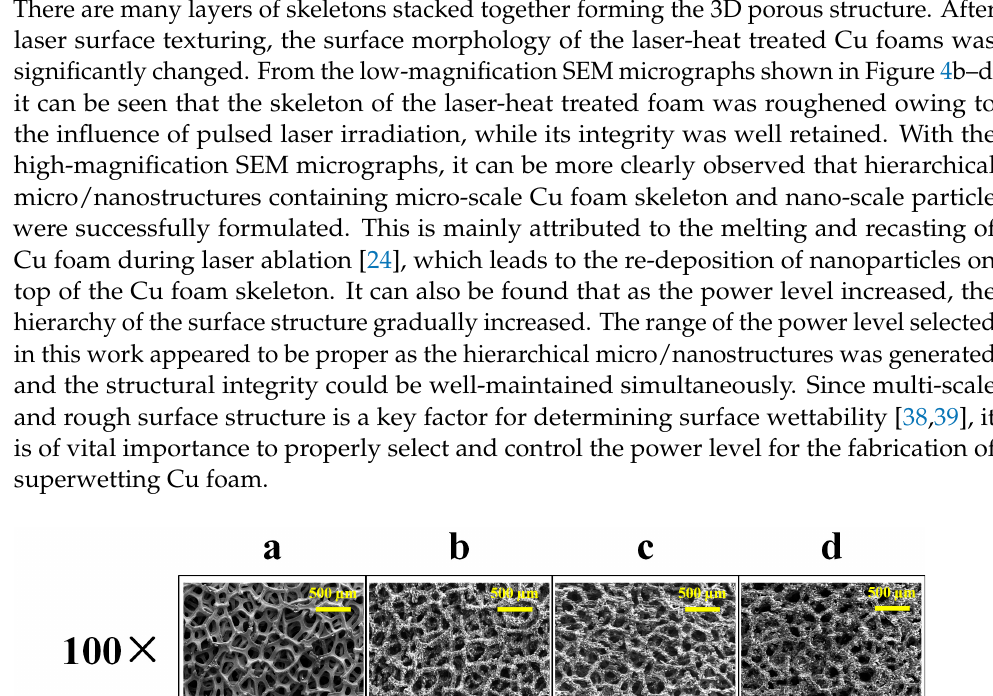
Figure 3. Images of untreated Cu foam and laser-heat treated Cu foams processed with different power levels.